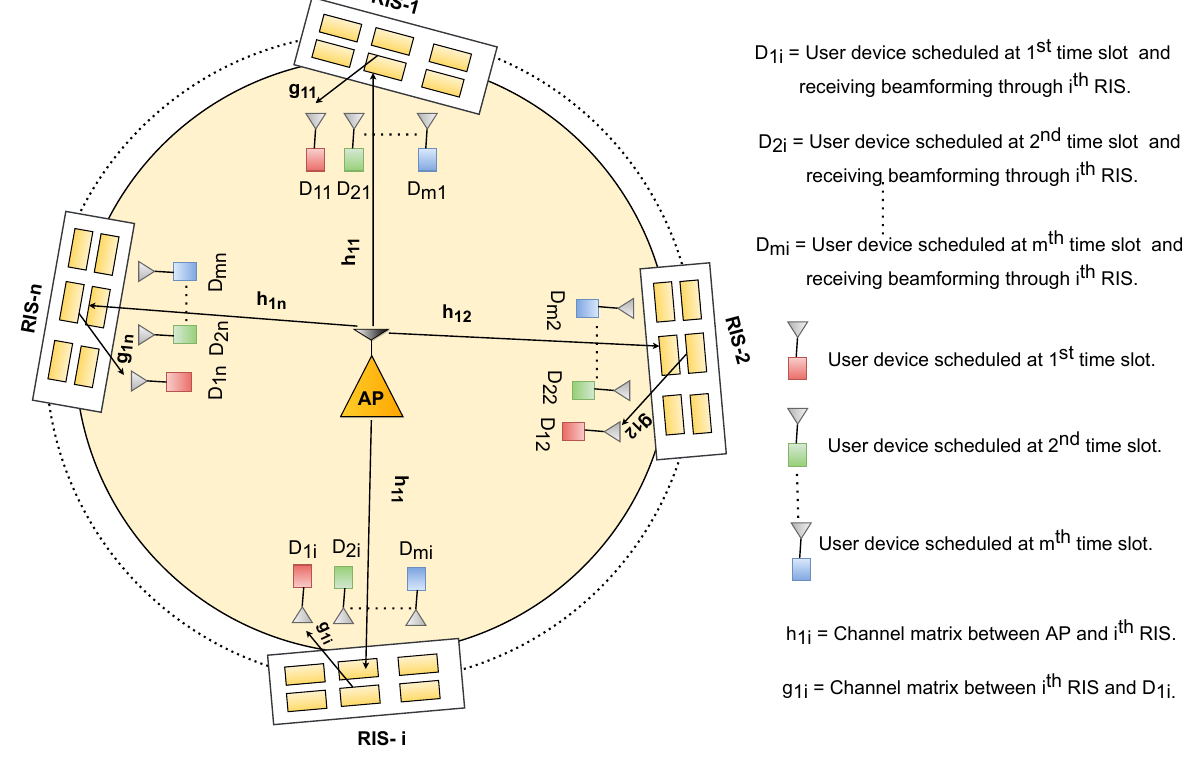
Figure 2. Overview of the TDMA-RIS assisted downlink NOMA system.